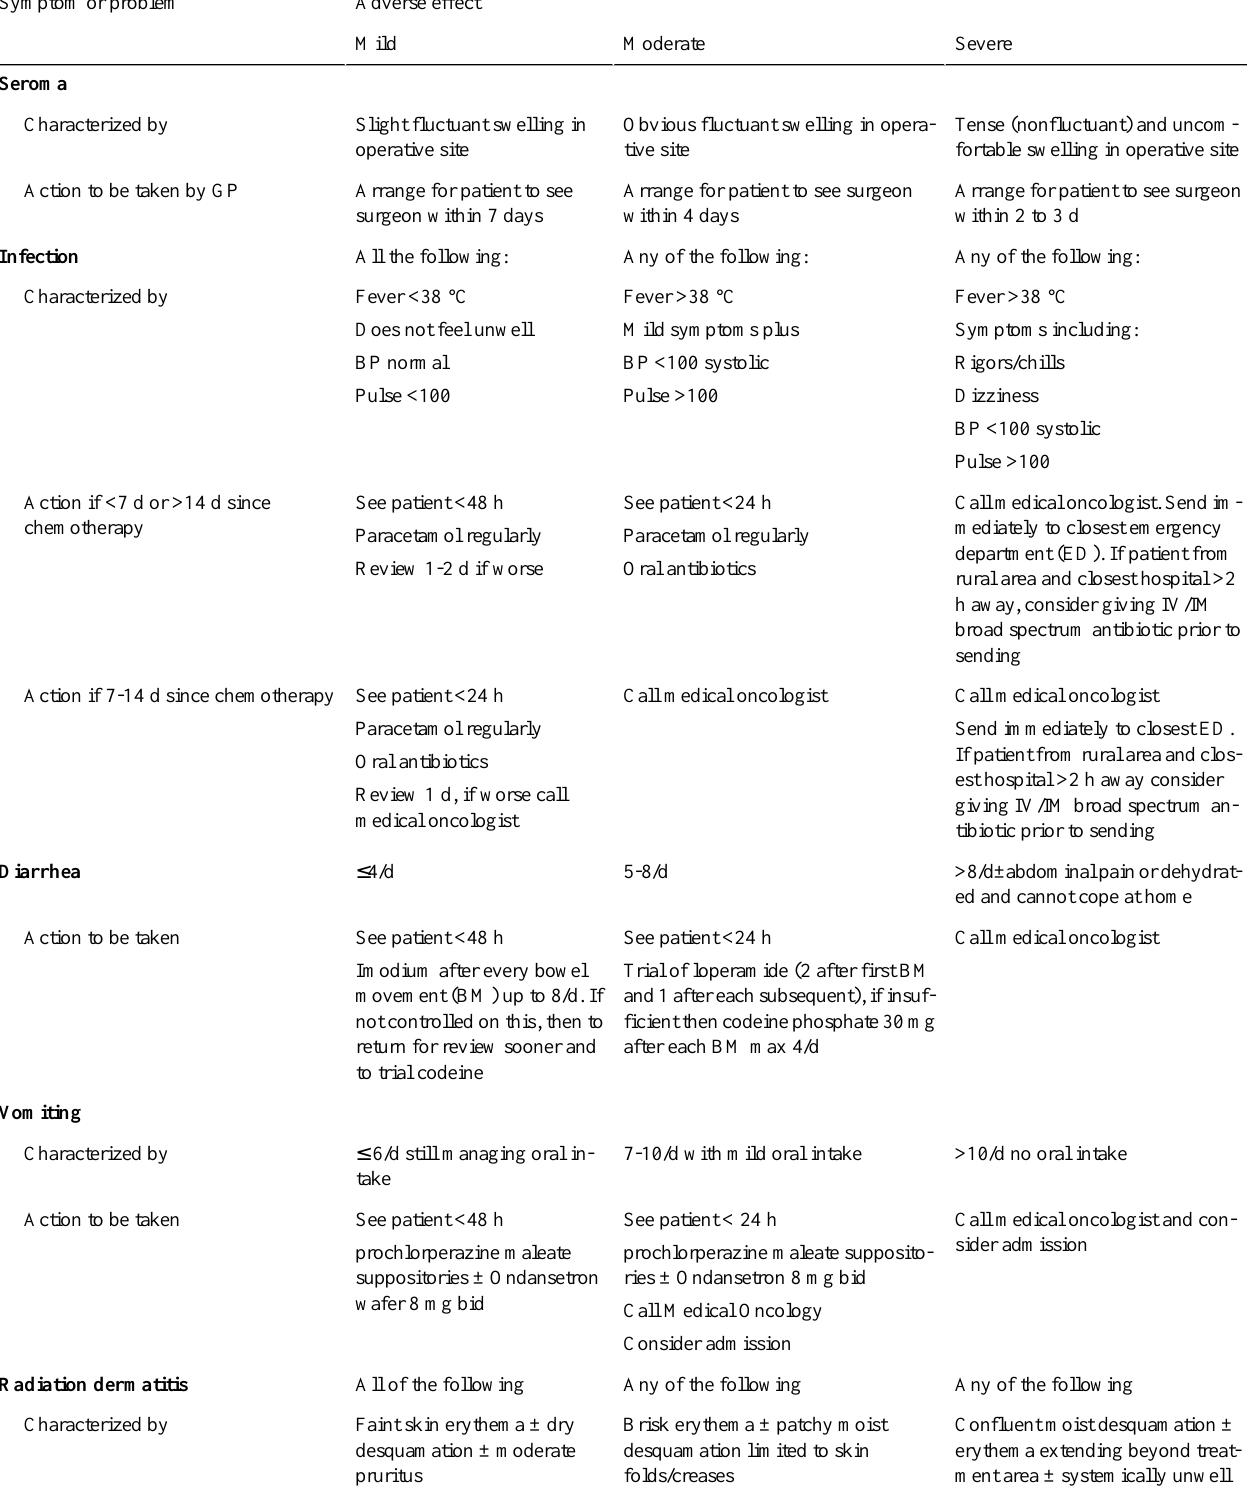
Table 1. Specific recommendations for management of symptoms or problems after treatment for breast